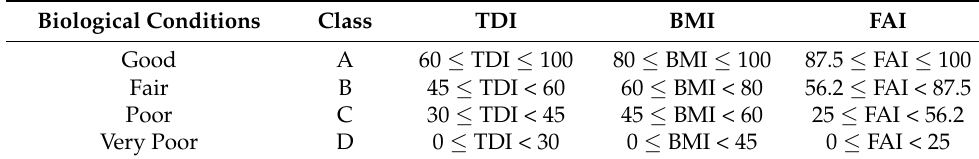
Table 3. Classification of biological indicators according to